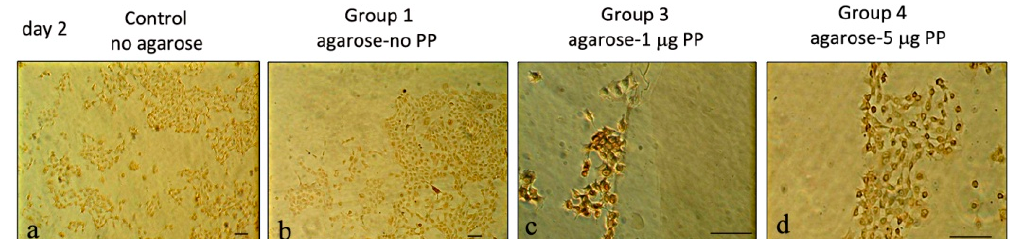
Figure 3. Col type I expression on Day 2 in rat dental pulp MRPC-1 cells:( a ) cells in control group (no agarose) showed weak anti-Col I activity; ( b ) border of Group 1 (agarose-no PP) also showed weak anti-Col I activity. The cells were scattered around the gel; ( c ) cells on the border of Group 3 (agarose-1 µ g PP) showed strong anti-Col I activity; and ( d ) cells around the border of Group 4 gel (agarose-5 µ g PP) showed mild anti-Col l activity. Scale bar = 100 µ m for all frames.